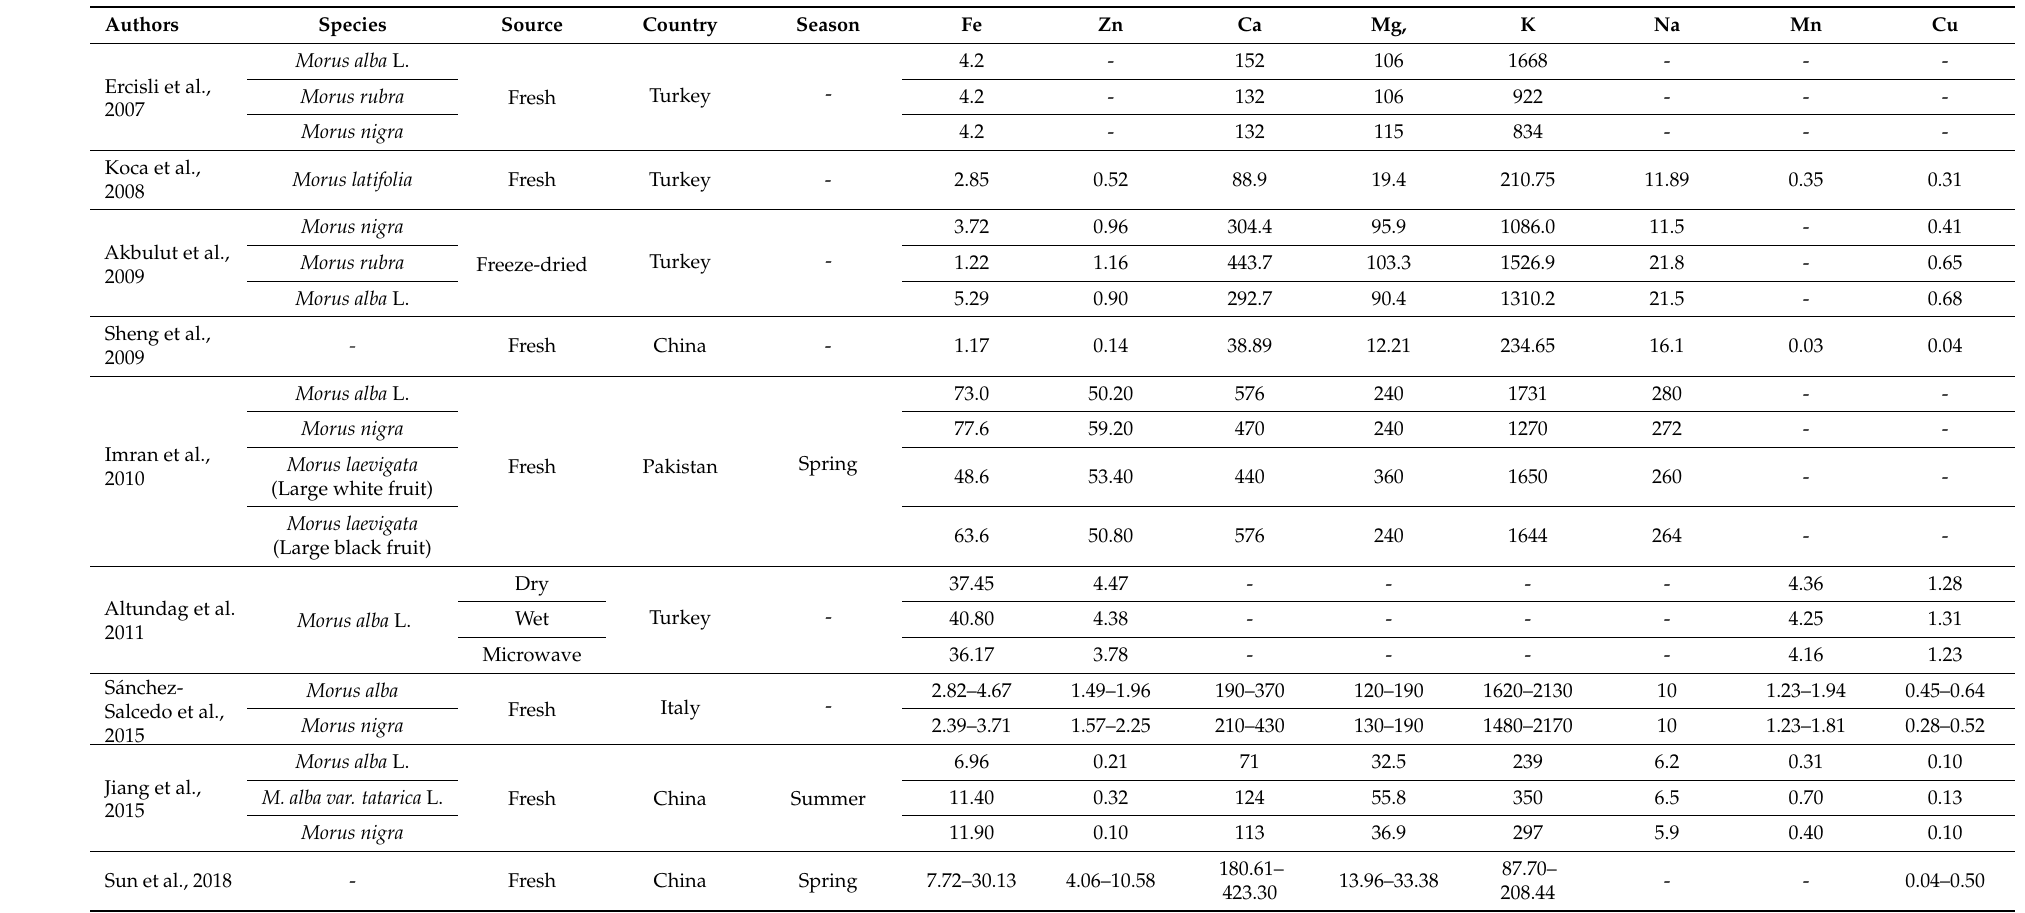
Table 2. Trace element composition of the mulberry fruits (mg/100